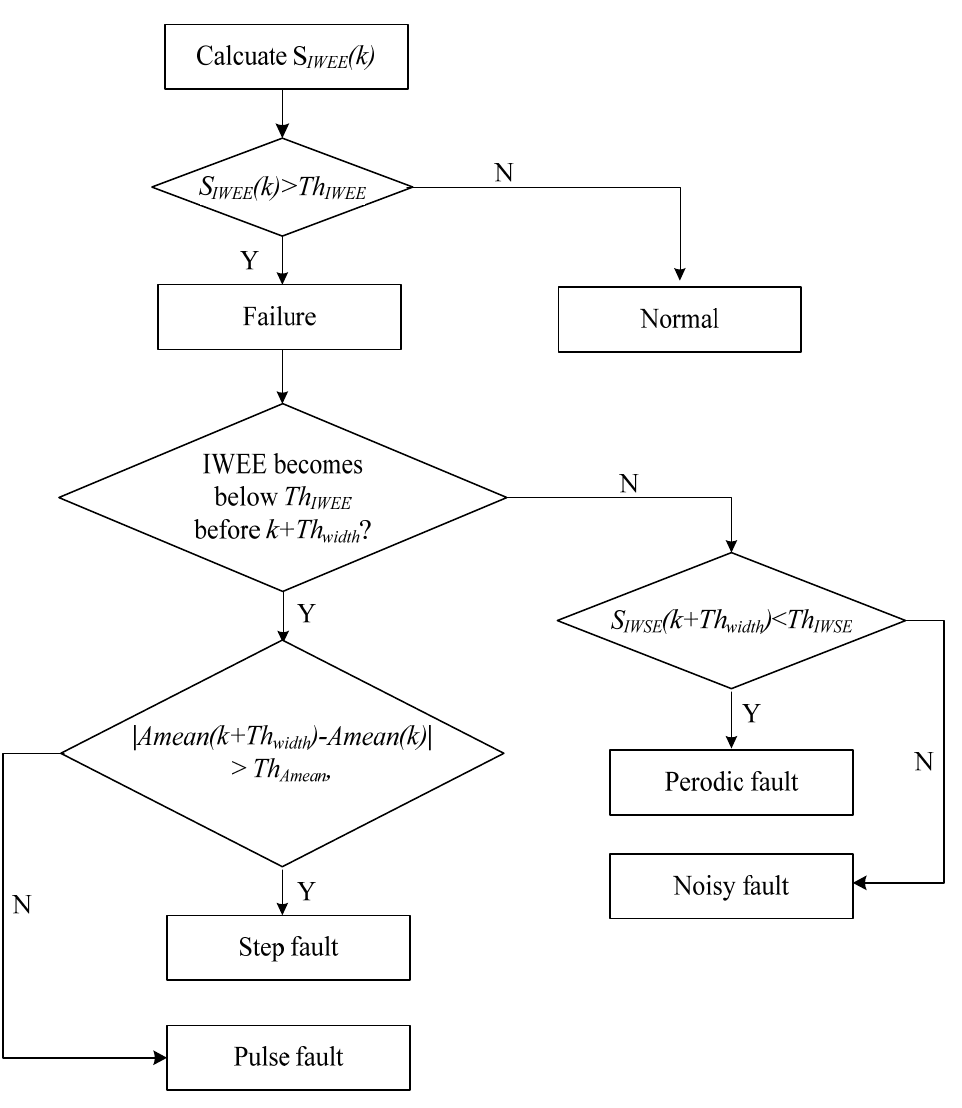
Figure 2. Flowchart of proposed sensors fault diagnosis